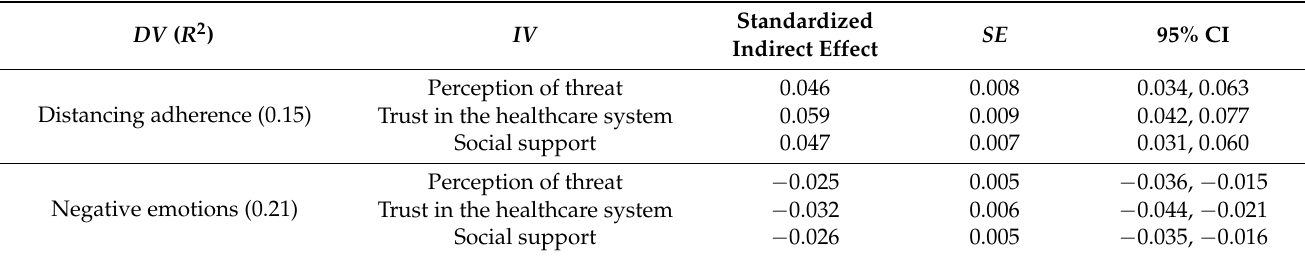
Table 4. Indirect relationships among threat, trust, and social support, and distancing adherence and negative emotions ( N = 1822). Standardized SE 95% CI DV ( R 2 ) IV Indirect Effect Perception of Distancing adherence (0.15)